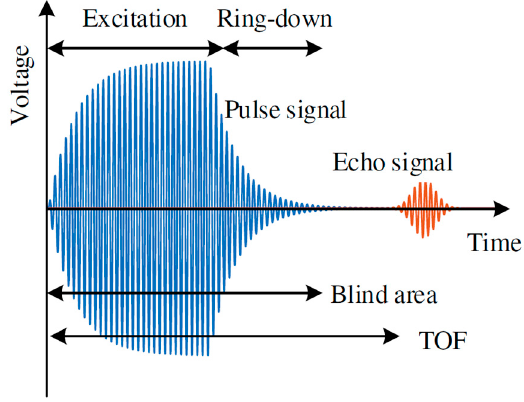
Figure 13. Block diagram of a pMUT rangefinder system using the cross correlation TOF method. Reproduced with permission from [33], Copyright 2010, IEEE.